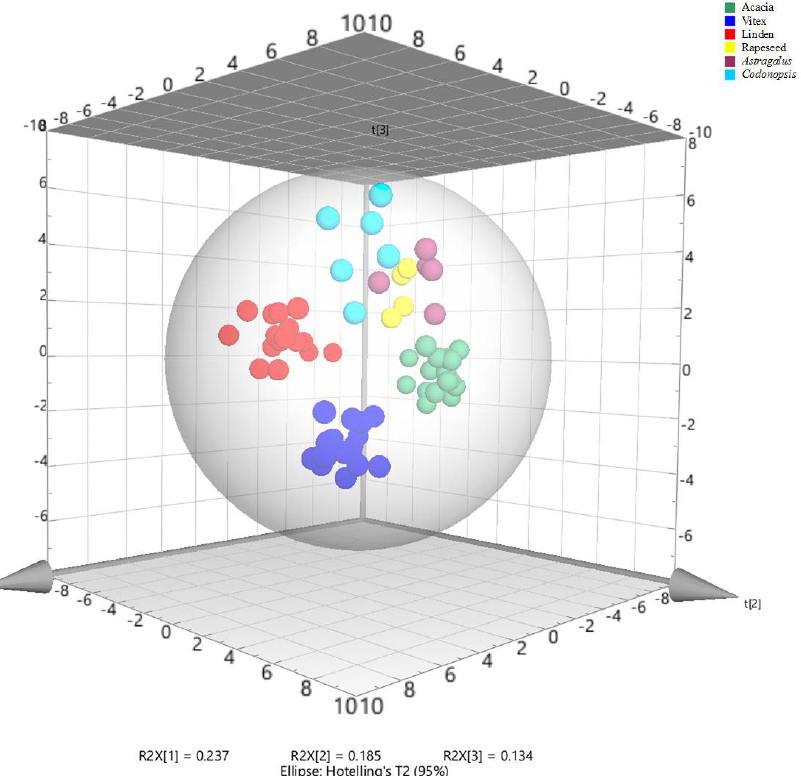
Figure 1. 3D PCA scores plots of honeys.